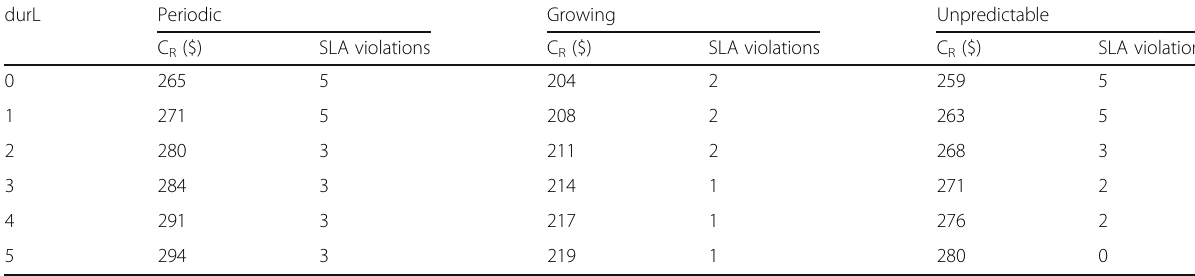
Table 10 Impact of increasing the durL on the cost factors durL Periodic